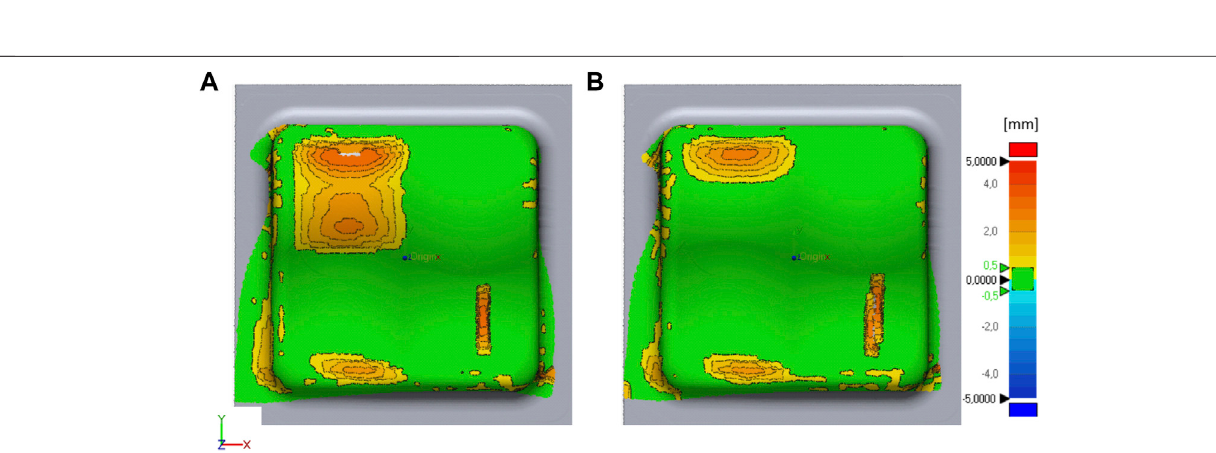
FIGURE 14 | Effects of (A) isotropic friction based on properties in fi ber direction, (B) isotropic friction based on properties transverse to fi ber direction plotted againstthebenchmarksimulation.Thedistancebetweenthebenchmarksimulation(reference)andmodi fi edsimulationiscolorcoded,wheregreenareasare±0.5 mm, yellow to red areas are > + 0.5 mm, and blue areas < − 0.5 mm